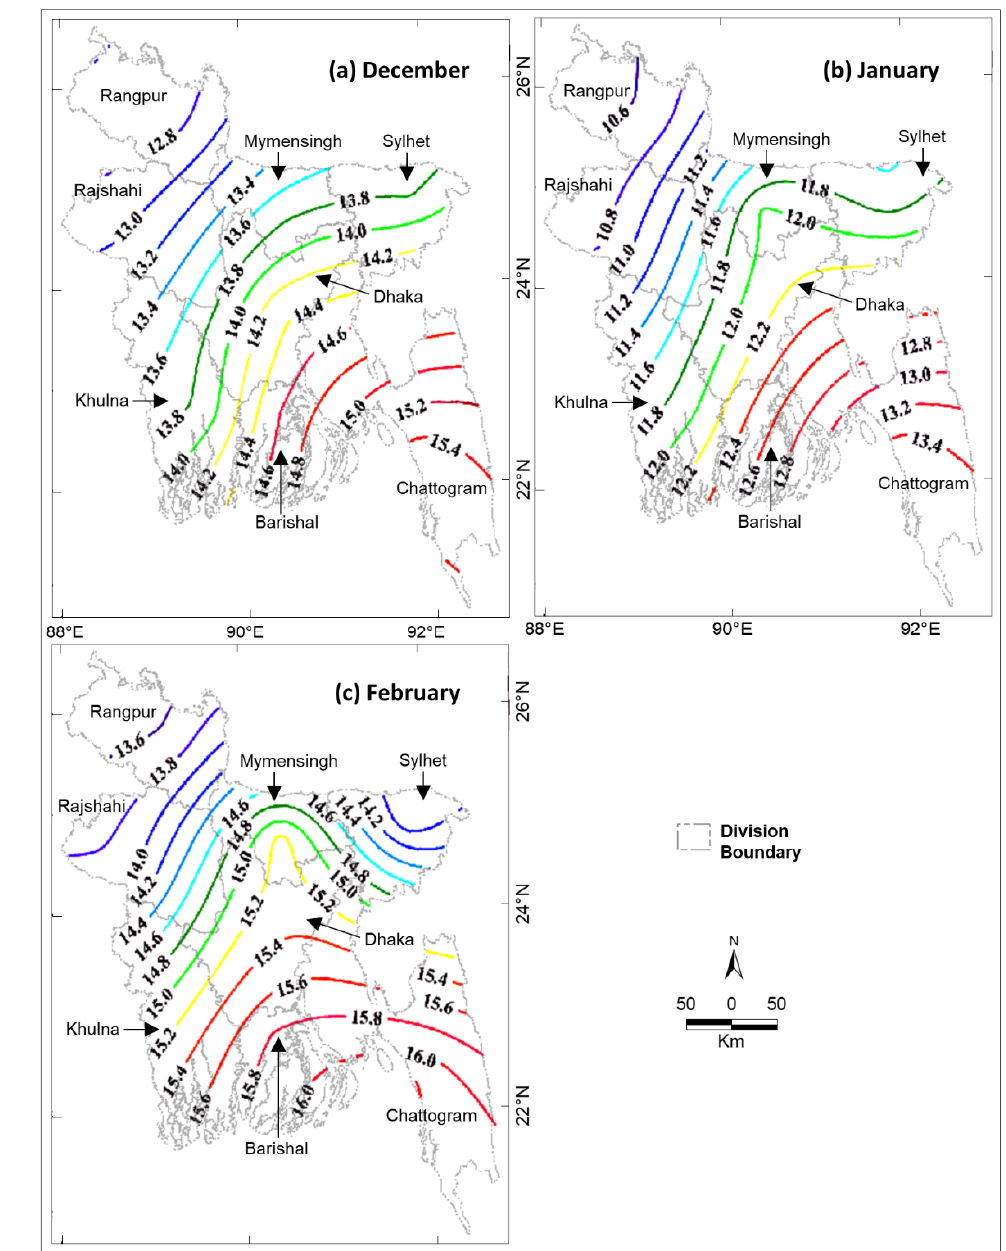
Figure 4. Isolines of the monthly average daily minimum air temperature (°C) in the division during the winter months of 2009 to 2021: ( a ) December, ( b ) January, and ( c ) February.